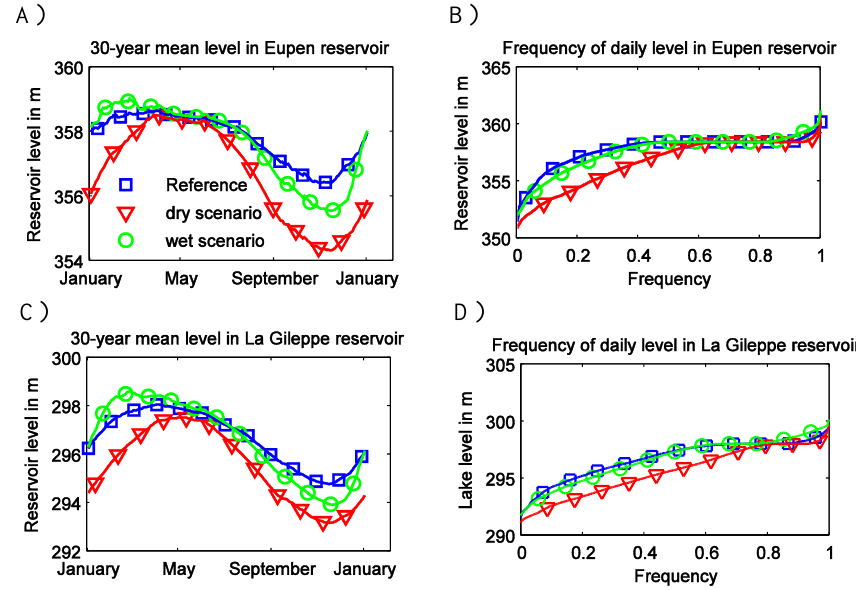
Fig. 5 Impacts of climate change on the reservoir levels in the time period 795 Figure 5. Impacts of climate change on the reservoir levels in the time period 2070–2100.